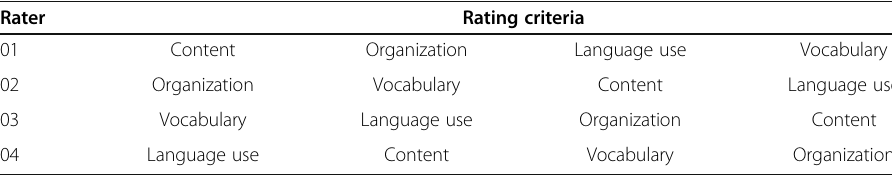
Table 1 Rating criteria order for expert